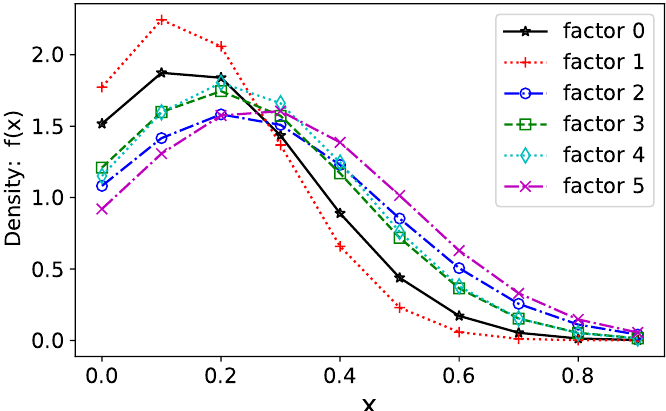
Figure 2. Density distribution computed using Equation